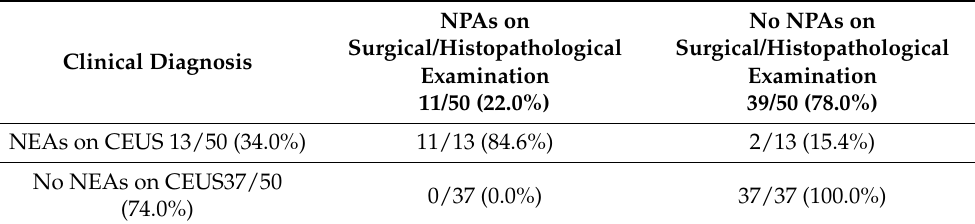
Table 3. Contrast-enhanced ultrasound data of abdominal hernia and its correlation with surgi- cal/histopathological evaluation.